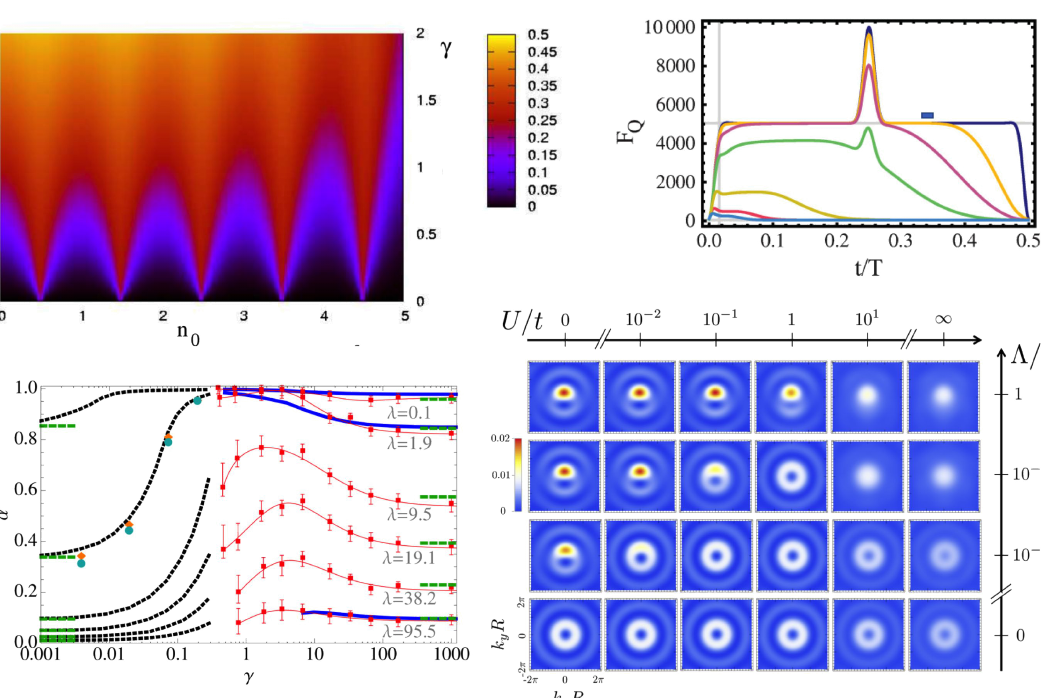
Figure 8: Top left: Number fluctuations in a Bose-Josephson junction as a function of the ratio γ of tunnel to interaction energy (vertical axis), and imbalance among the two wells (horizontal axis) taken from [ 106 ] . Top right: Quantum Fisher in- formation for a Bose-Josephson junction, as a function of time following a sudden quench of the tunnel energy to zero, at increasing phase noise [ 109 ] . Bottom left: Persistent current amplitude for one-dimensional bosons on a ring as a function of the interaction strength, for various values of barrier strength λ [ 124 ] . Bottom right: Time-of-flight images of an expanding one-dimensional Bose gas on a lattice ring with barrier, carrying a superposition of angular momentum states, at varying interactions U and barrier strength Λ [ 128 ]